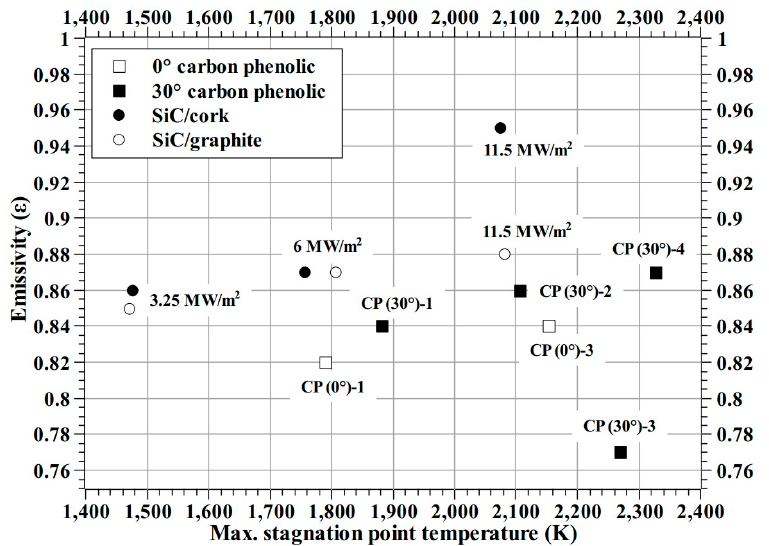
Figure 27. Test wise estimated emissivity ( ε ).